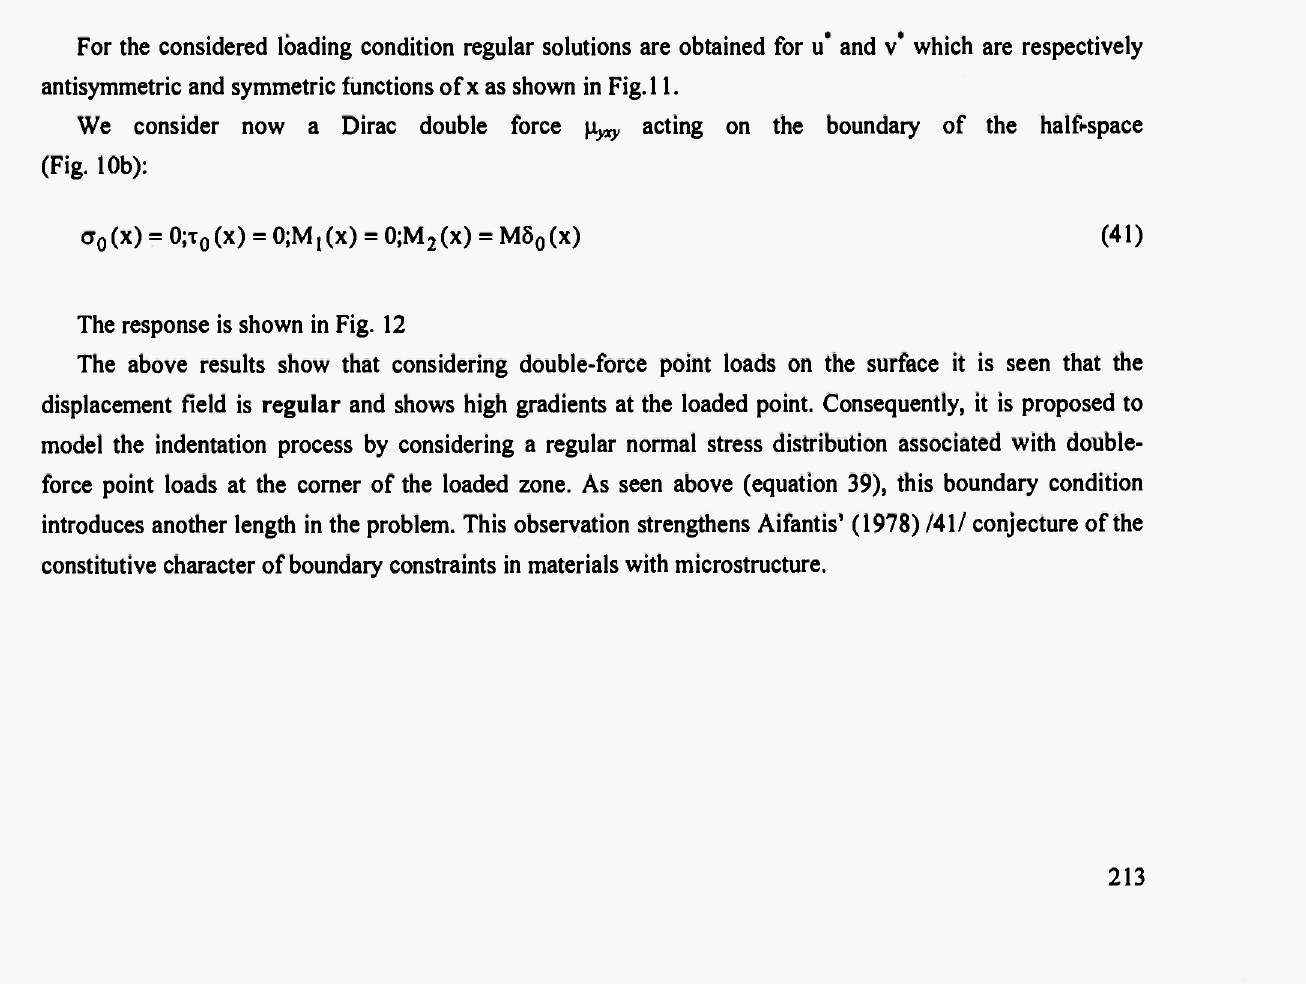
Fig. 10: Double-stress components and strain